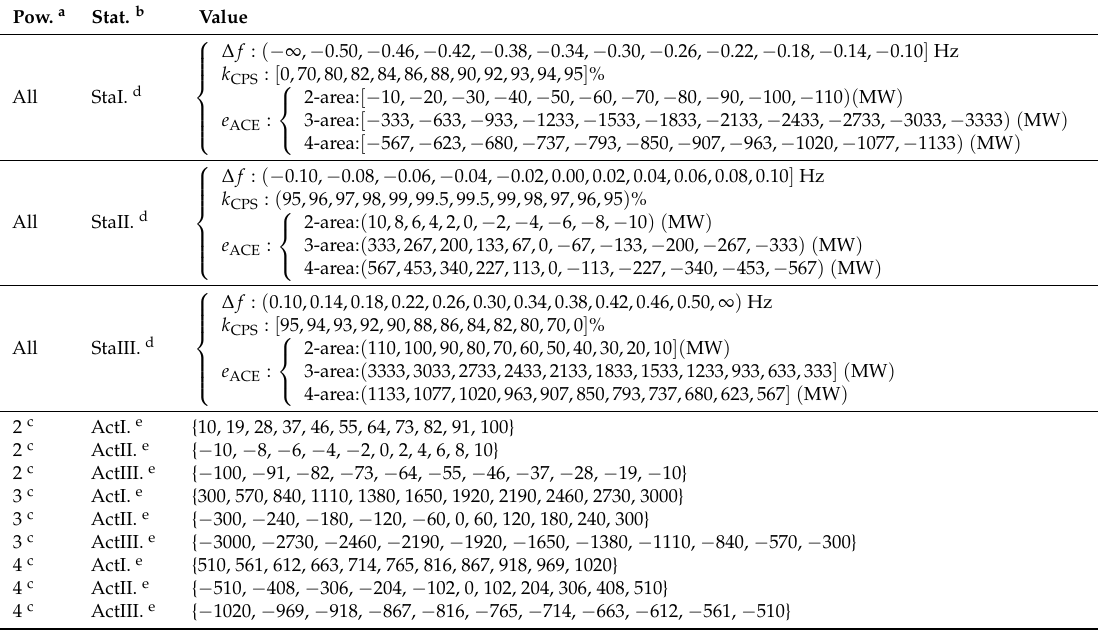
Table 1. State ranges and action sets of RL-I, RL-II, and